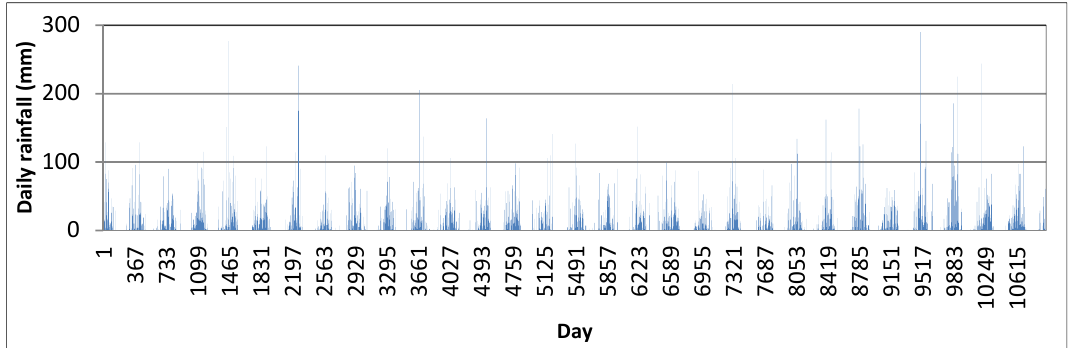
Figure 3. Daily rainfall for Darwin, Australia, for a 30-year time series.